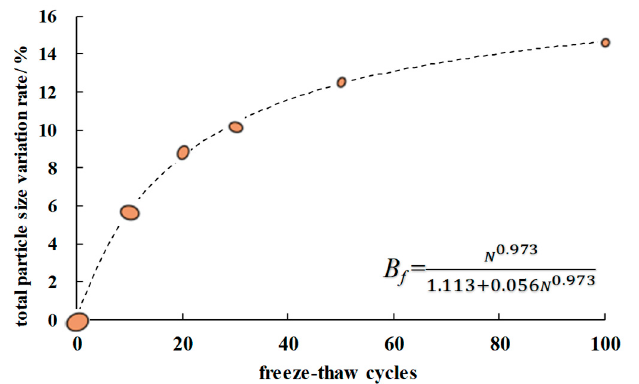
Figure 12. The effect of freeze–thaw cycles on the total particle size of silt.